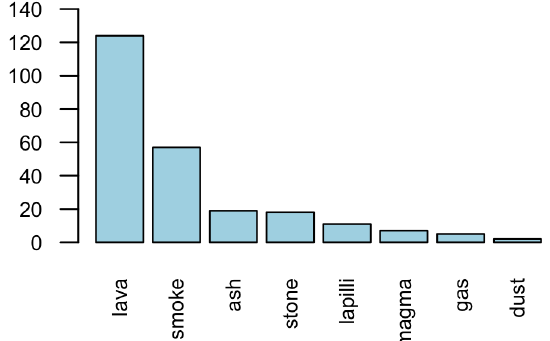
Figure 2. Frequency of words related to friends, families, and com- munities. The categories shown in the figure include the follow- ing Italian terms: community – cittadini (citizens), abitanti (resi- dents), persone, and gente (people); friends – amico (friend) and compagno (companion); parents – mamma (mum), madre (mother), papà (dad), and padre (father); family – famiglia (family); sib- lings – fratello (brother) and sorella (sister); grandparents – nonna (grandma) and nonno (grandpa; note that the Italian language does not have a formal expression for grandmother or grandfather); and aunts and uncles – zia (aunt) and zio (uncle). Both singular and plu- ral and masculine and feminine terms are always counted.